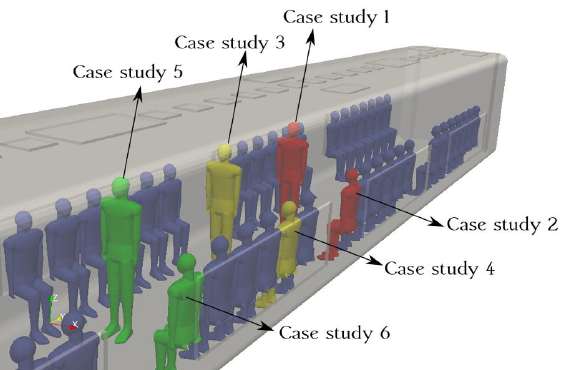
Figure 5. Positions and locations of the evaluated cases. Table 1. The main characteristics of the evaluated case studies.